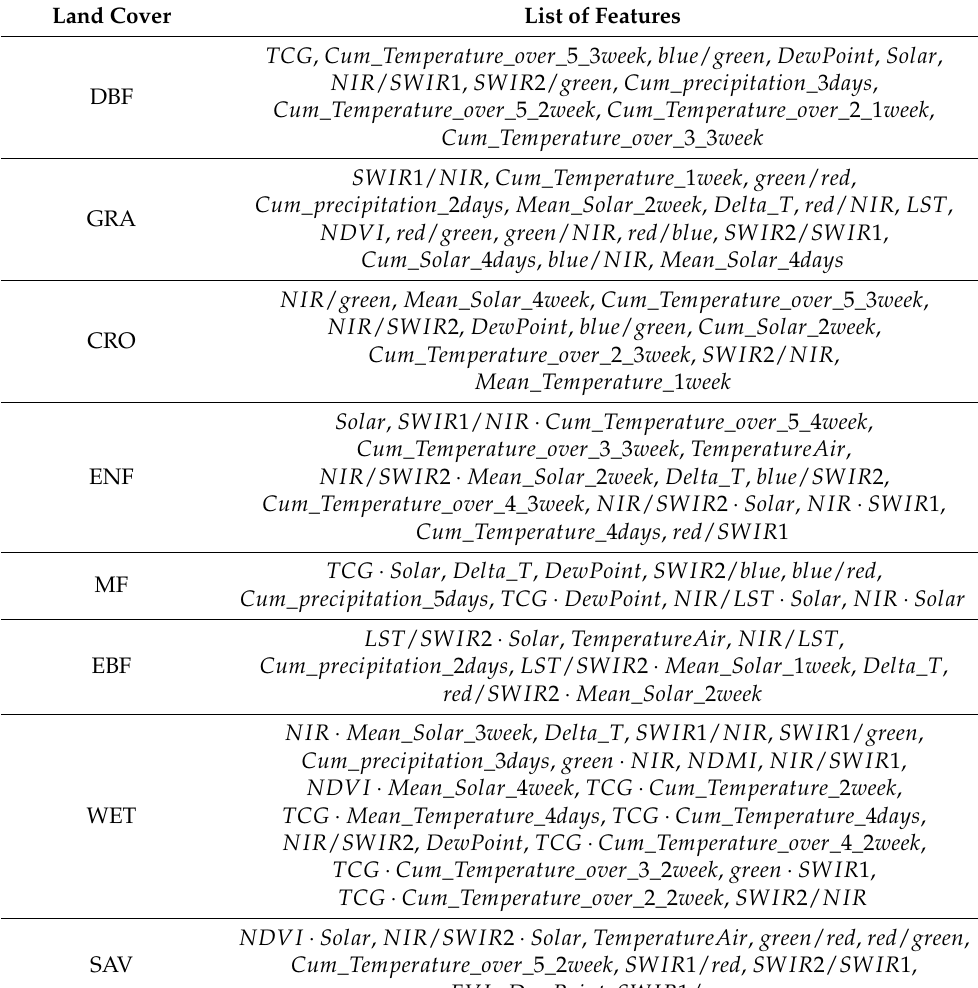
Table 3. Feature sets for predicting NEE for each IGBP class (detailed description in Appendix